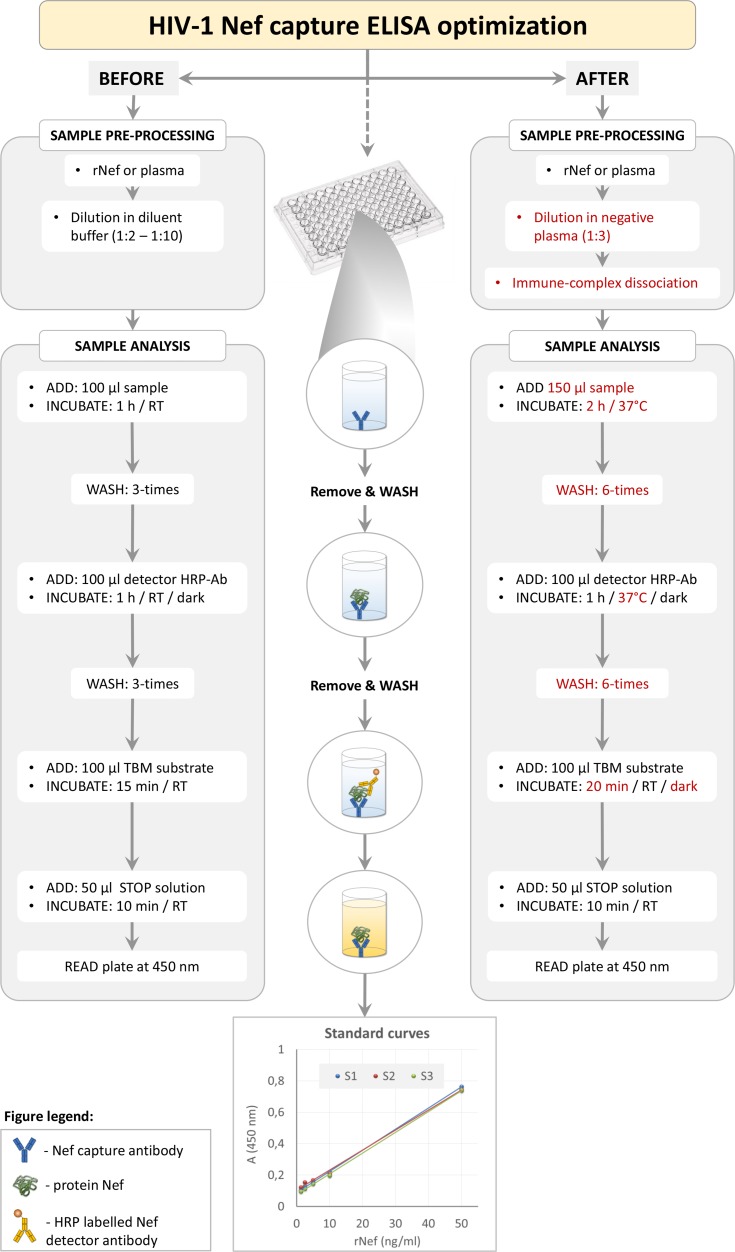
Schematic representation of HIV Nef ELISA optimization.Key assay optimizations are highlighted by the red text. Three linear standard curves of serially diluted Nef in negative serum (1.25 ng/ml to 50 ng/ml), designated as S1, S2 and S3, are shown as assay readouts. rNef, recombinant Nef; RT, room temperature; HRP-Ab, horseradish peroxidase-conjugated antibody; TBM, 3,3',5,5'-tetramethylbenzidine; A, absorbance. For details, see Materials and methods.